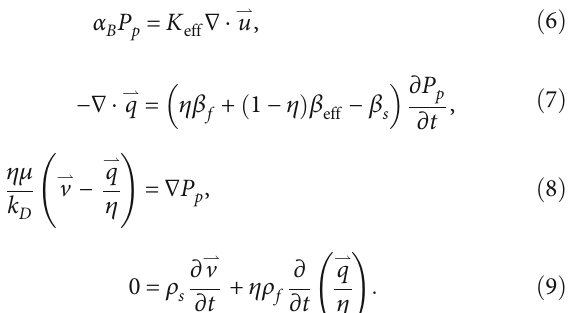
Figure 1: A schematic propagation of fl uid pressure in pores ( P pumping well changes the well pressure ( P w ) as sinusoidal function of time ( t ), which propagates (with attenuation) into the aquifer. Note that this paper solves the eigenvalue problem and the resulting functions of wave velocity and attenuation with argument frequency are independent of 1D, 2D, or